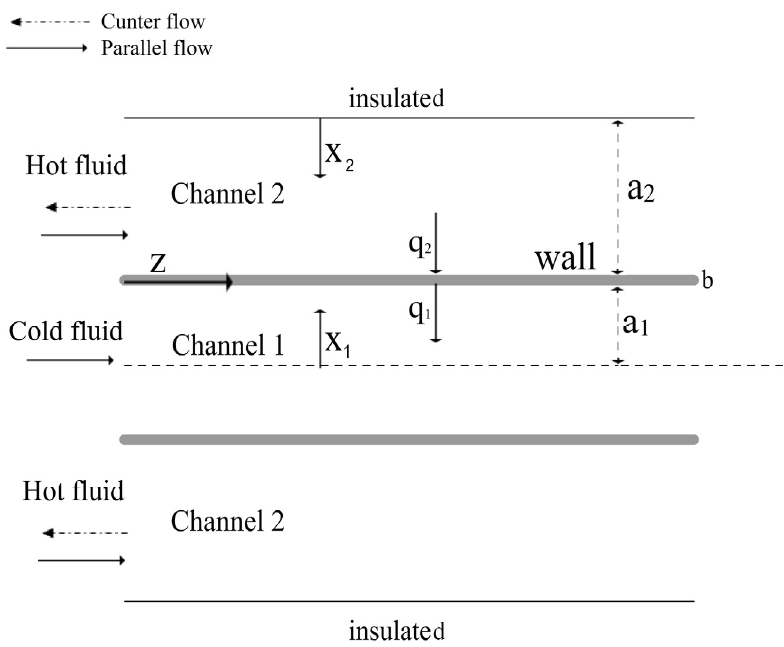
Figure 1. Plate heat exchanger